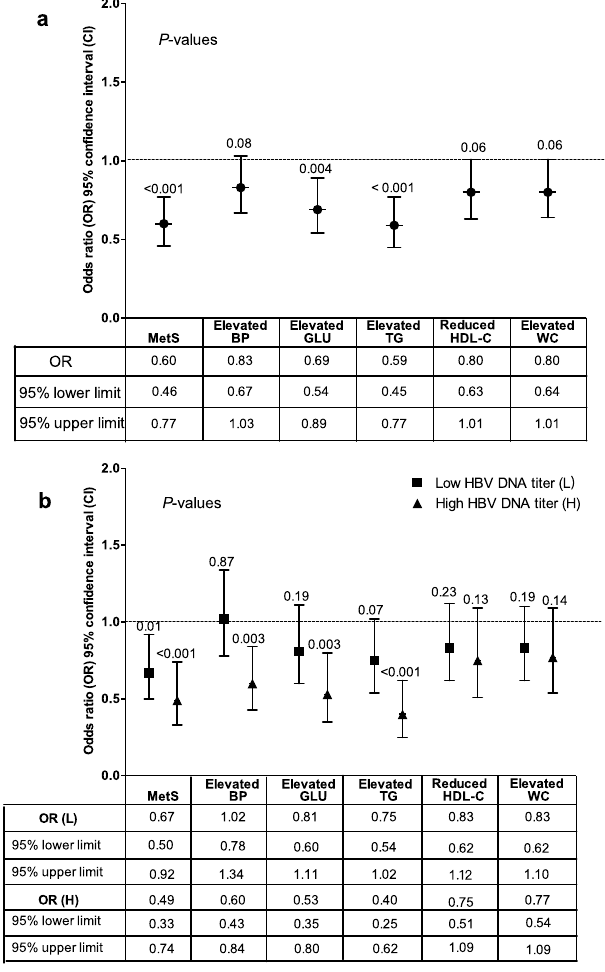
(OR = 0.60, 95% CI: 0.46–0.77), elevated GLU (OR = 0.69, 95% CI: 0.54–0.89) and elevated TG (OR = 0.59, 95% CI: 0.45–0.77). ( b ) Association between HBV DNA titers and MetS. Lower HBV DNA titers decreased the risk of MetS (OR = 0.67, 95% CI: 0.50–0.92), but did not decrease its constituents; higher HBV DNA titers decreased the risk of MetS (OR = 0.49, 95% CI: 0.33–0.74) and its three constituents. All the results were analyzed after adjustment for age, sex, abnormal liver function, Aflatoxin B1 exposure, MC-LR exposure, alcohol drinking, cigarette smoking, labor strength, education level, family income, and fat, salt, vegetable and fruit